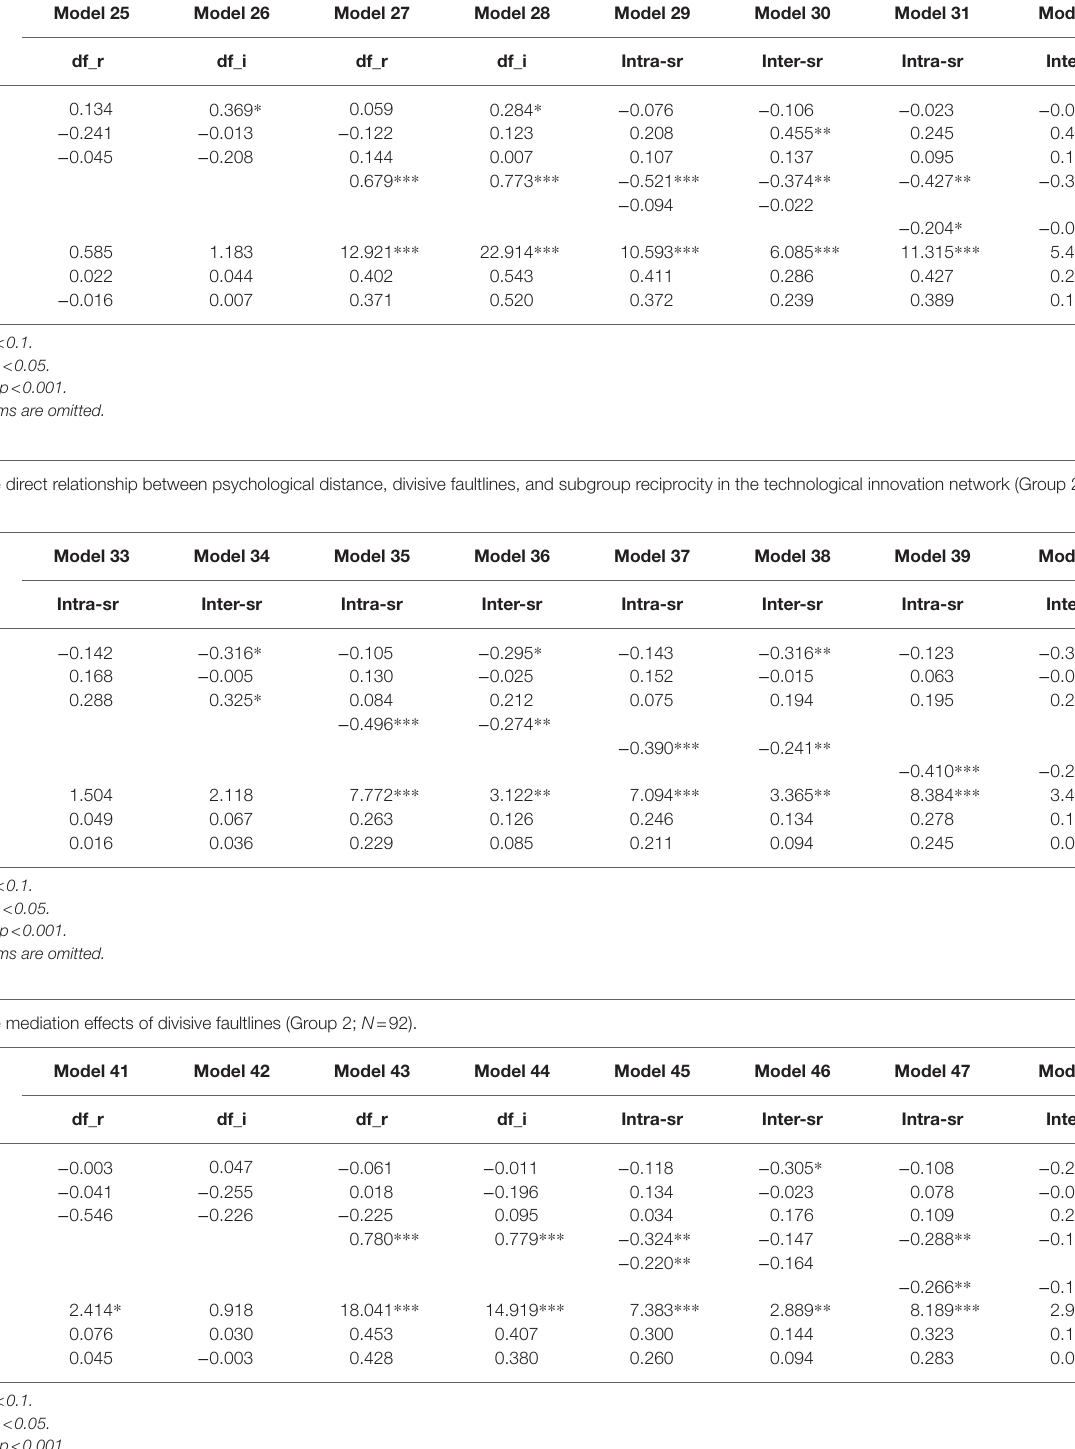
TABLE 7 | The mediation effects of the divisive faultlines (Group 1; N = 82). Variable